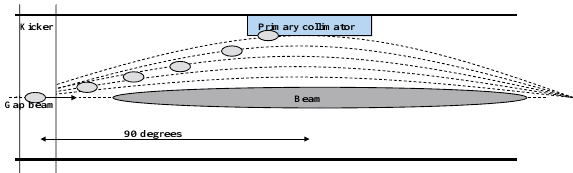
FIG. 8. (Color) Schematic view of the beam-in-gap (BIG) cleaner. The beam circulating between bunches is coherently kicked and drifts towards the vacuum pipe. In a small number of turns (10–20) it hits the scraper that acts as the main aperture restriction in the ring.